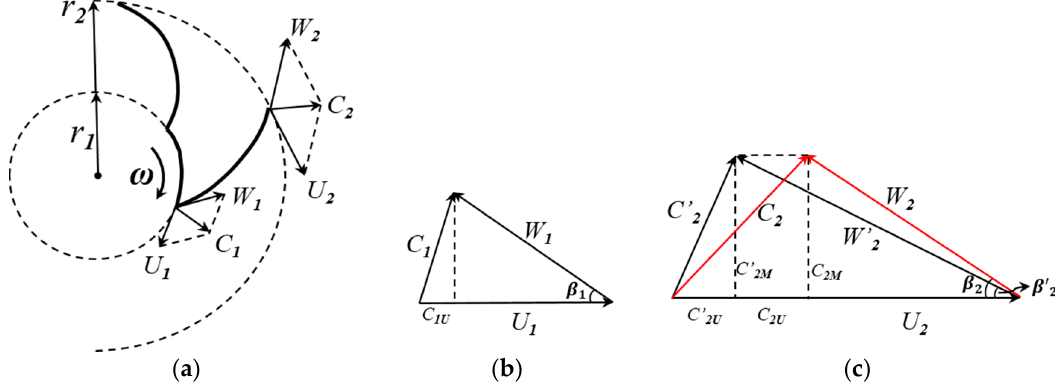
Figure 3. Velocity triangles. ( a ) Schematic of impeller flow channel; ( b ) inlet velocity triangle; ( c ) outlet velocity triangle.